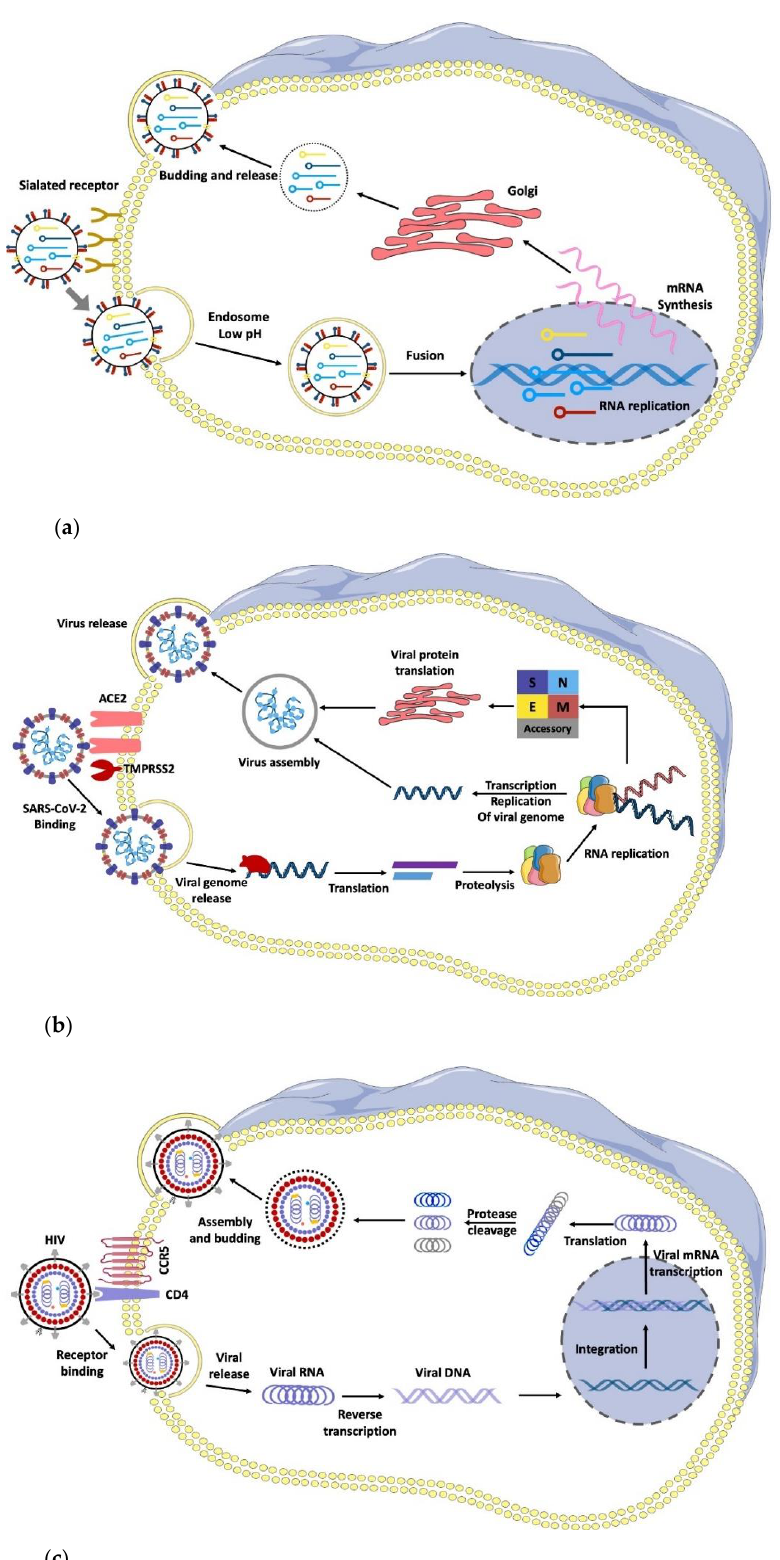
and genome replication. Viral mRNA is translated into polyproteins, which are cleaved by the viral protease. Functional proteins assemble with copies of the viral genome at the cell membrane and mature virions bud from the surface.